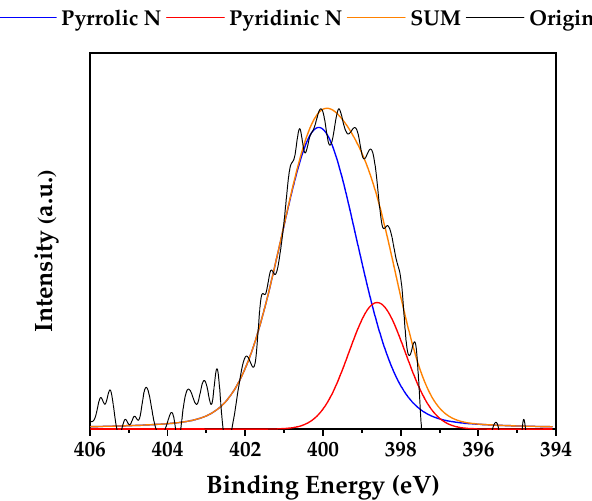
Figure 3. XPS profiles of catalysts: ( a ) O 1s; ( b ) Pd 3d.